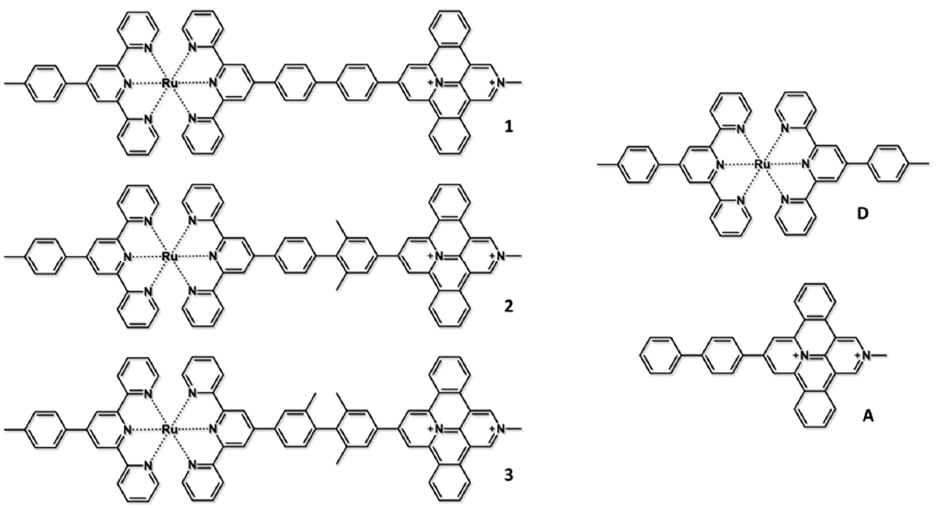
Figure 6. ( left ) Structural formulas of 1, 2, and 3 bichromophoric species systems; ( right ) the model compounds concerning the donor (D) and acceptor (A) moieties.